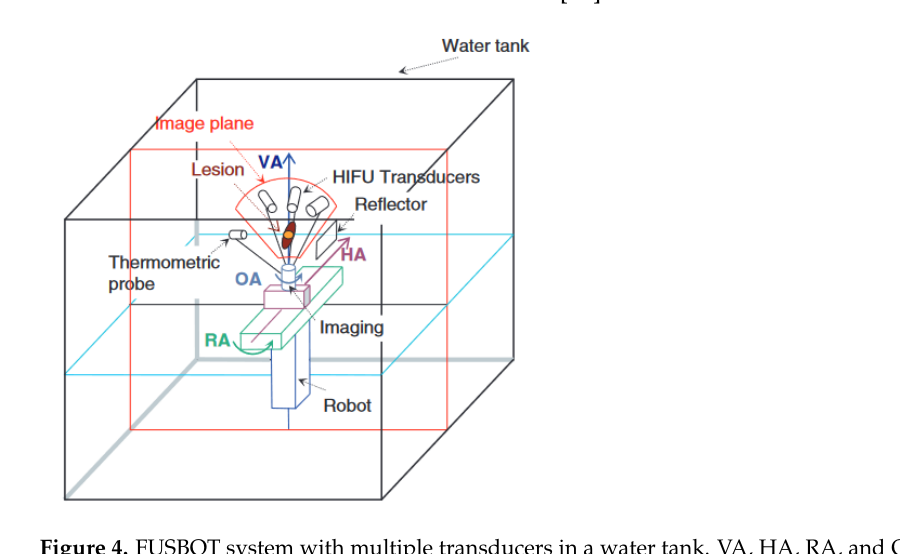
Figure 4. FUSBOT system with multiple transducers in a water tank. VA, HA, RA, and OA represent the vertical, horizontal, rotation, and orientation axes, respectively